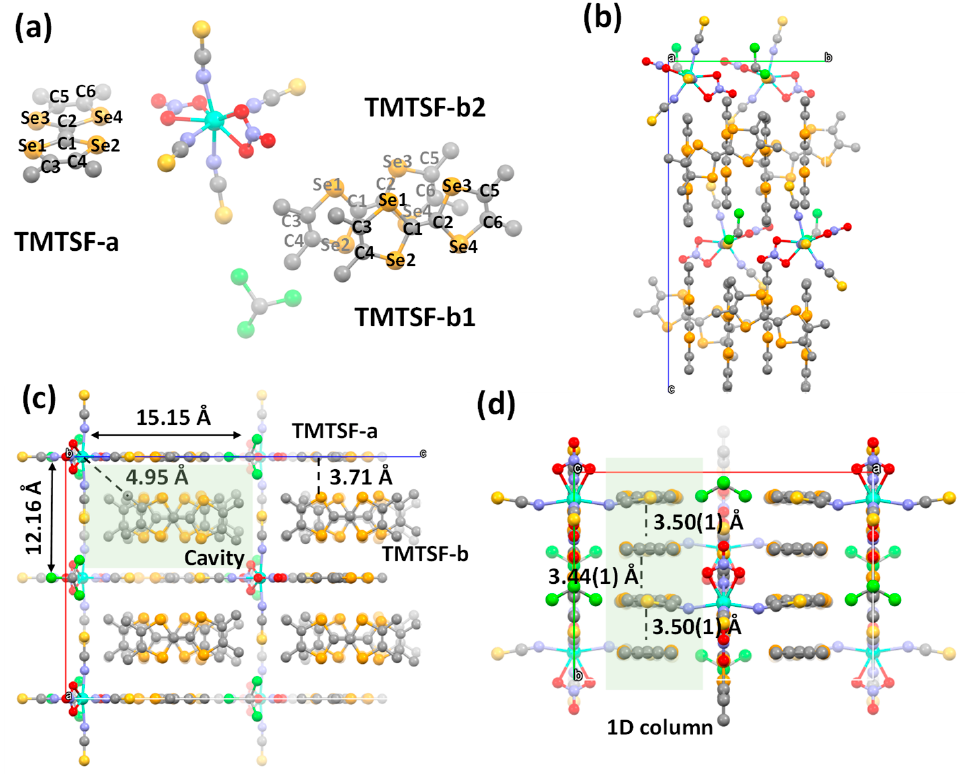
Figure 1. ( a ) X-ray crystal structure of 1 . Crystal packing along the ( b ) a-axis, ( c ) b-axis and ( d ) c-